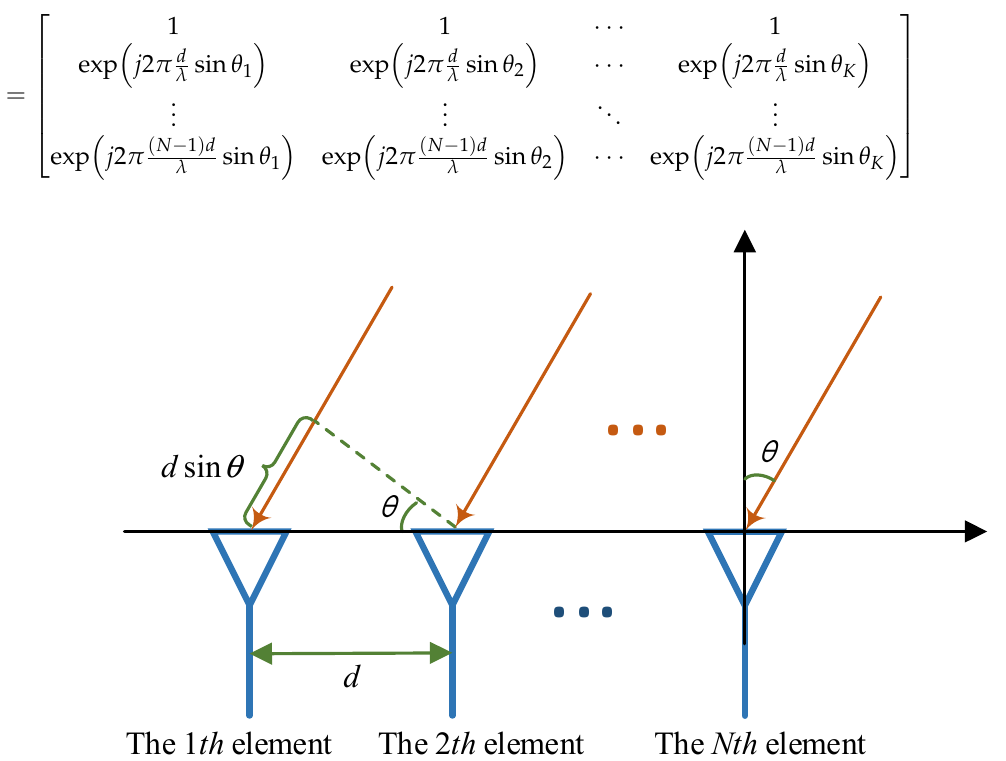
Figure 1. The system model for the DOA estimation with the far-field narrowband source.